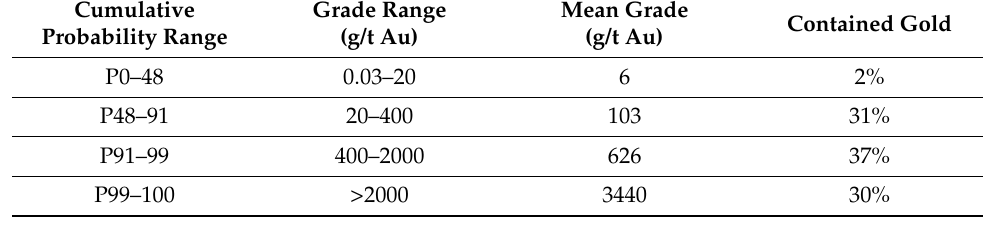
Table 3. Analysis of the combined LV grade data.